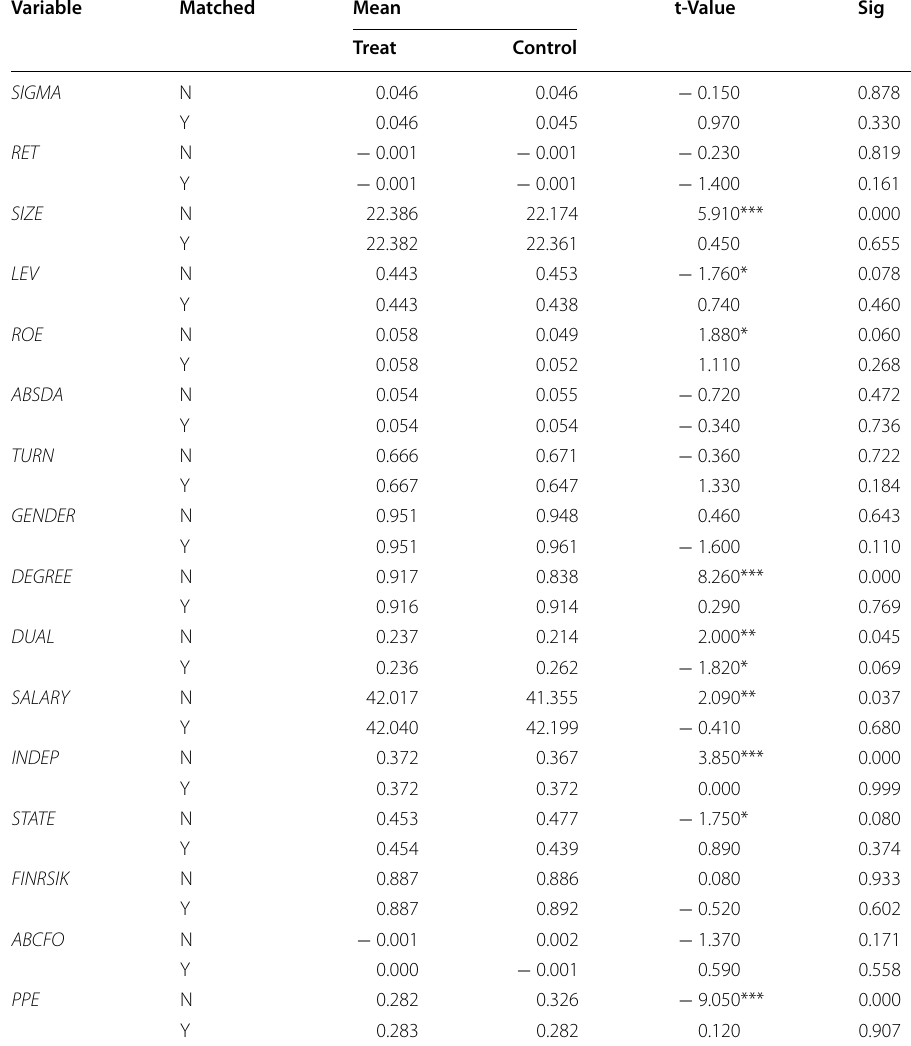
In this paper, ***, **, and * represent the significance levels of 1%, 5%, and 10%,